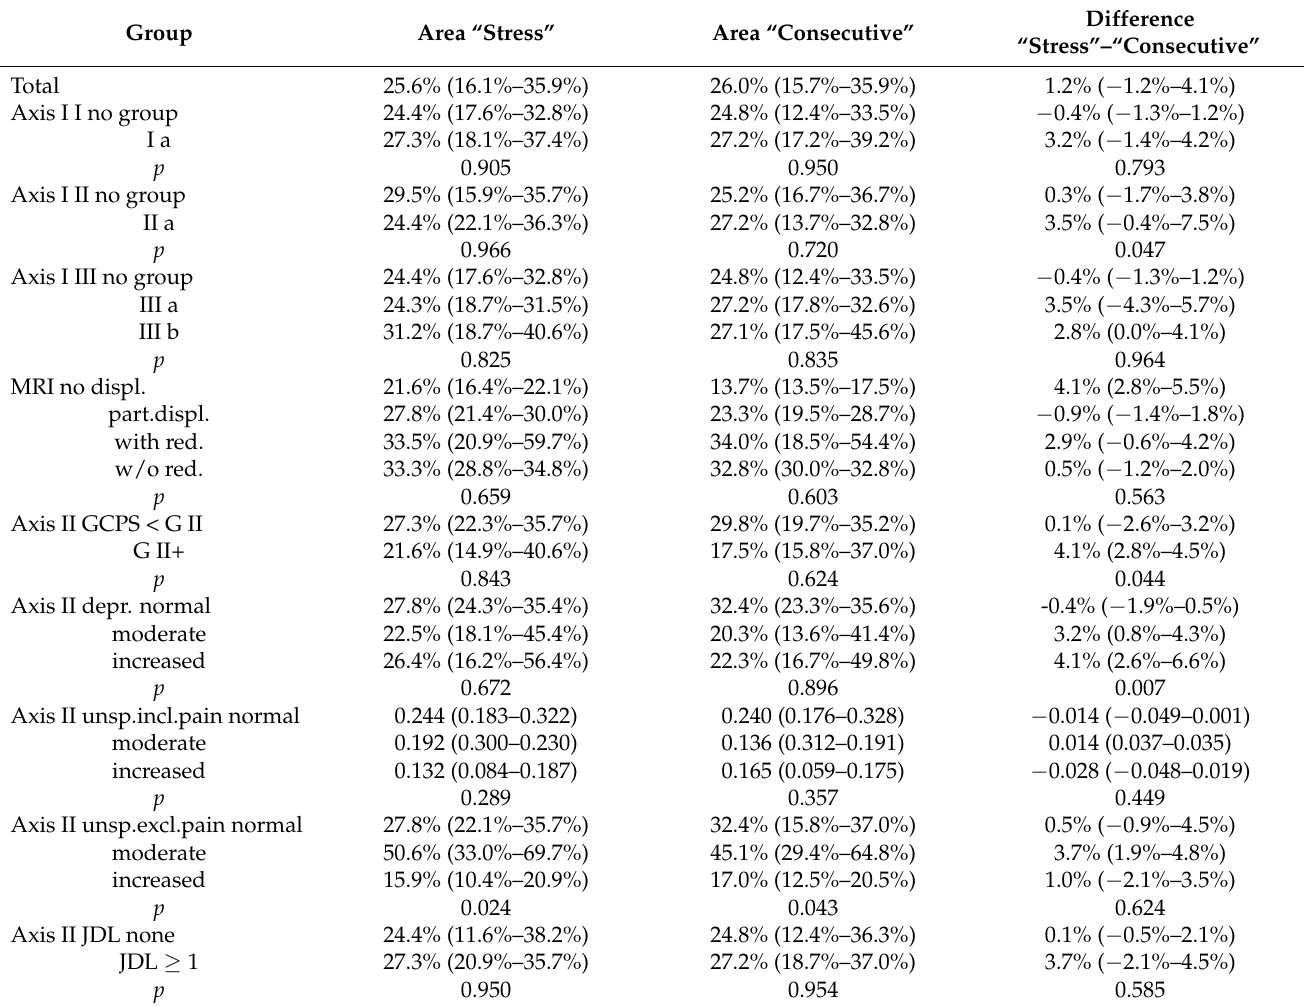
Table 1. Attrition area (in percent of total area) under stress and on consecutive nights and difference between these areas (median and interquartile range) stratified for RDC/TMD axis I and II subgroups and MRI findings ( p -values from